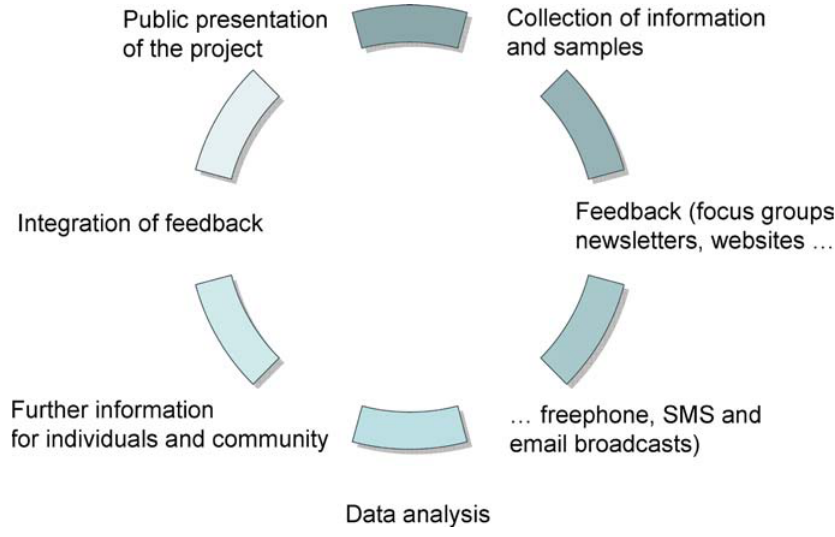
Figure 1. Informed Consent as a